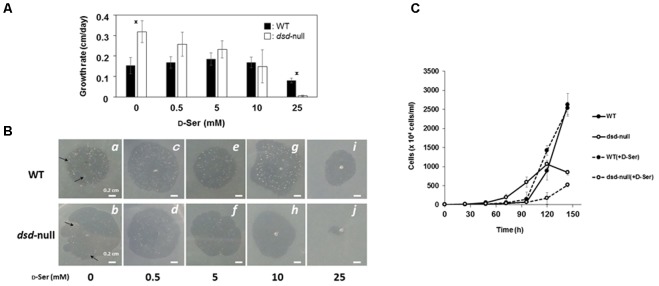
Growth and development of WT and dsd-null cells and the effect of exogenous D-Ser. D. discoideum cells were grown on Klebsiella aerogenes on 5LP agar plates containing indicated D-Ser concentrations. (A) The rates of plaque diameter increase of WT (closed bars) and dsd-null cells (open bars). Data are represented as the mean ± SD (n = 3). Asterisks indicate significant differences (Student’s t-test, P < 0.05). (B) Photographs of plaque of WT (Top) and dsd-null cells (Bottom) were taken when the plaque diameter reached approximately 1-cm (4 days in b,d, 5 days in a,c,e–i, 7 days in j). Multicellular structures are indicated as arrows. (C)
D. discoideum cells were grown in HL5 liquid medium in the presence or absence of 10 mM D-Ser. Data are represented as the mean ± SD (n = 3).